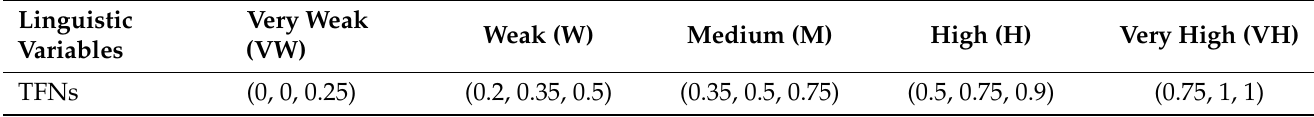
Table 4. Variables in linguistics for assessing reliability.